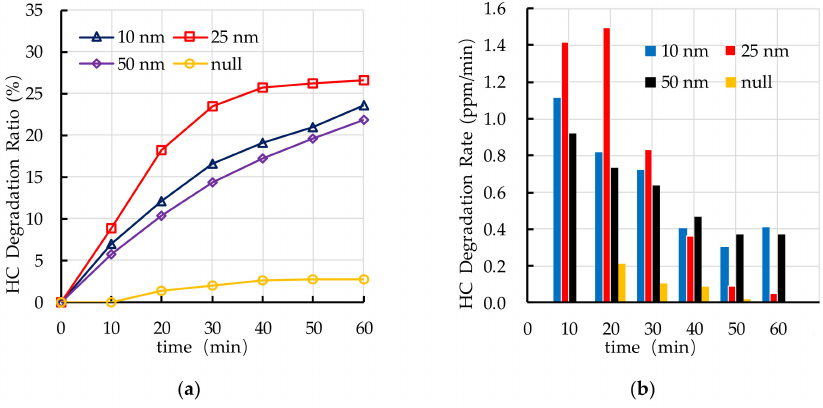
Figure 10. E ff ect of TiO 2 particle size on photocatalytic degradation of HC: ( a ) HC degradation ratio; ( b ) HC degradation